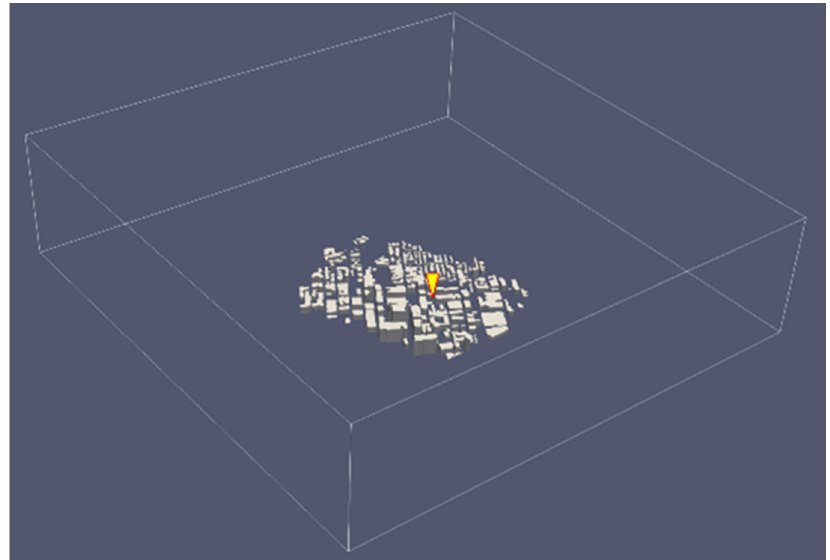
Figure 5. Schematic of the computational domain and boundary conditions (four vertical boundary openings represent inflows or outflows depending on the incoming wind direction with the location of the weather station indicated by the yellow triangle.